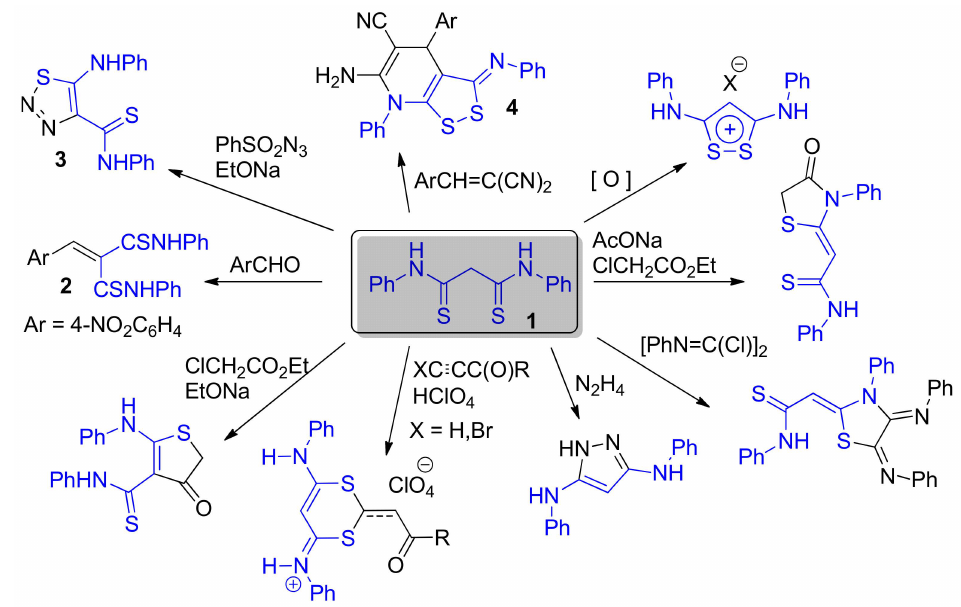
Scheme 1. The diversity of reported dithiomalondianilide reactions.